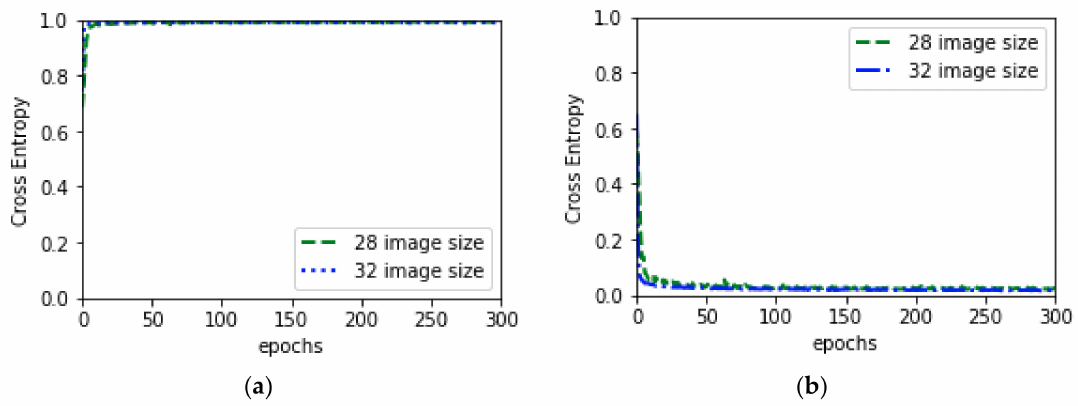
Figure 11. Final behavior of Autoencoder: ( a ) depicts the combine validation accuracy and ( b ) depicts combine validation loss while training Autoencoder 500